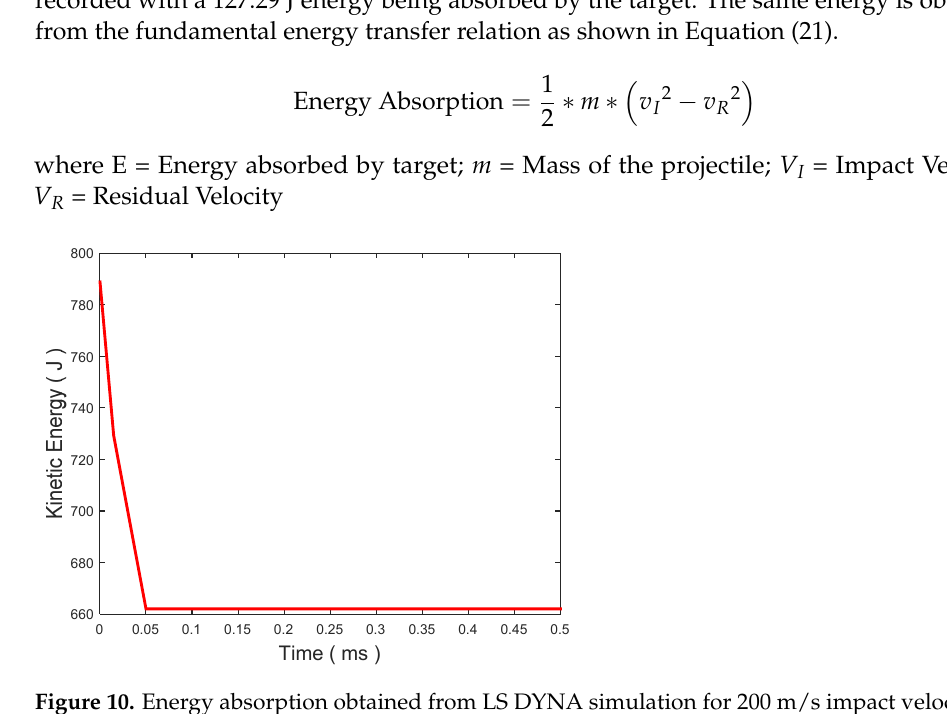
Figure 9. ( a ) Residual velocity vs. impact velocity. ( b ) Energy absorption vs. impact velocity—for 3.18 mm target thickness.